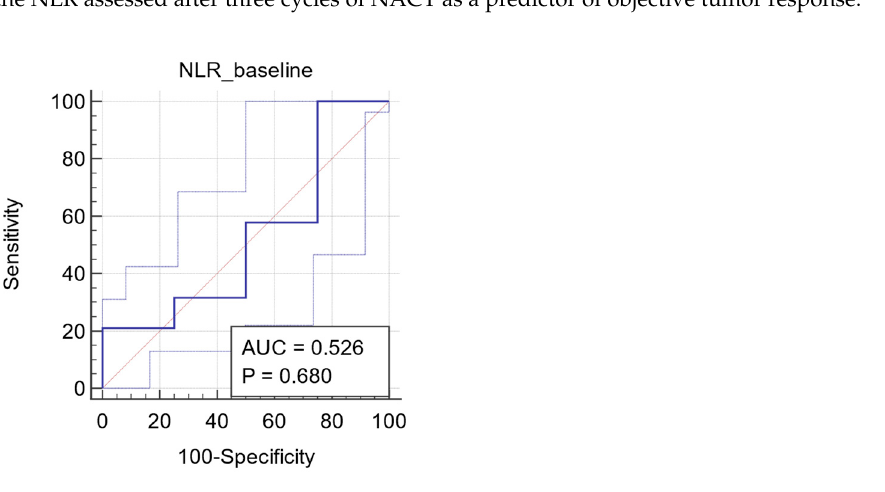
Figure 4. ROC curve for baseline NLR. Plot of the receiver operating characteristic curve of the NLR assessed at baseline as a predictor of objective tumor response.